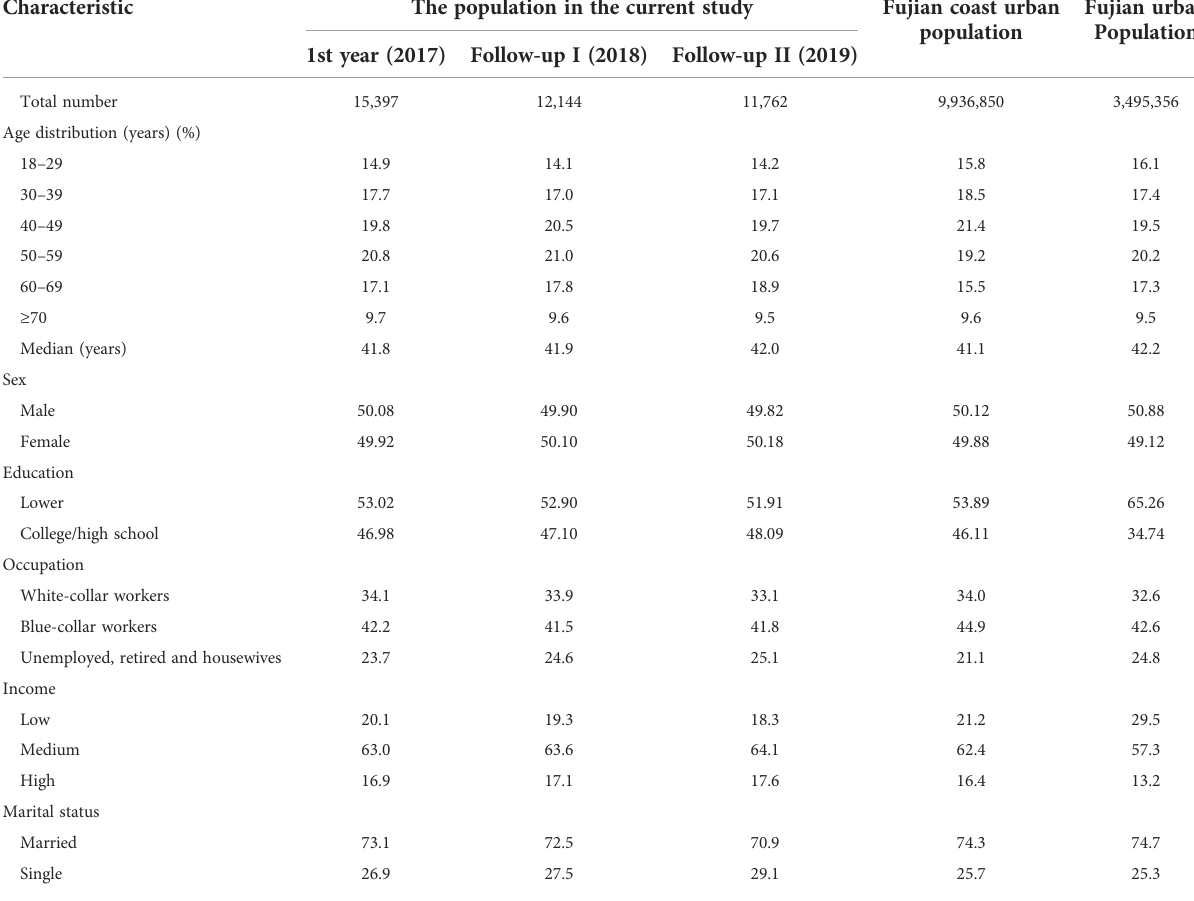
TABLE 1 Distribution of demographic characteristics and general socioeconomic indicators among different urban populations.